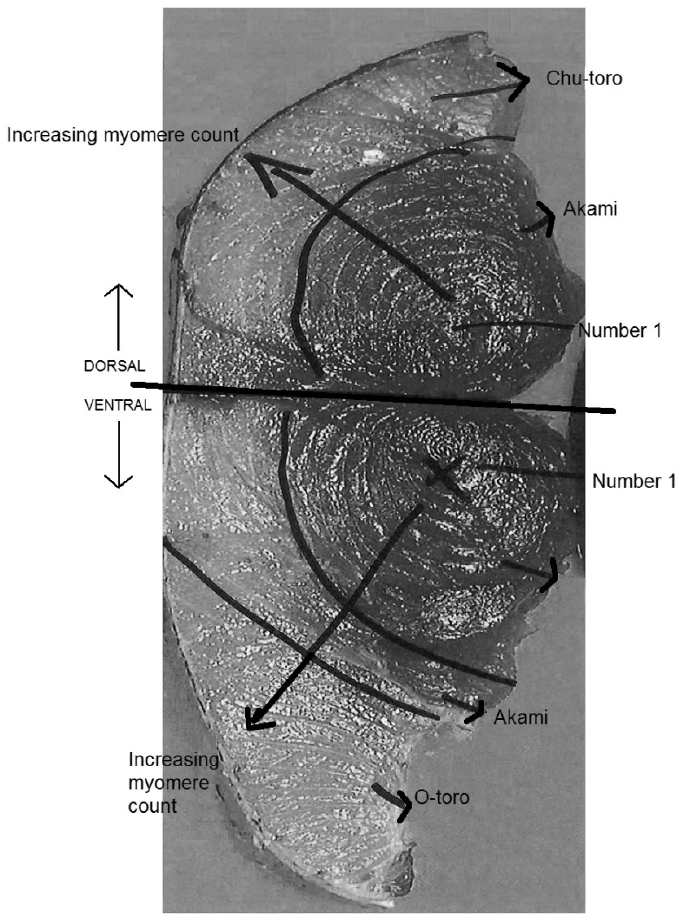
Figure 1. Photograph of southern bluefin tuna, Thunnus maccoyii (SBT) transverse sectional steak indicating myomere structure (including myomere number 1) and location of market tissue cuts (akami, chu-toro,